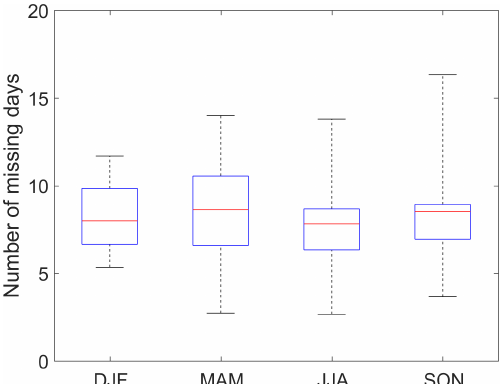
Figure 4. Distribution of number of missing days across different seasons, summarised from 39 catchments with a missing data rate ranging from 8% to 12% (i.e. 10% missing data